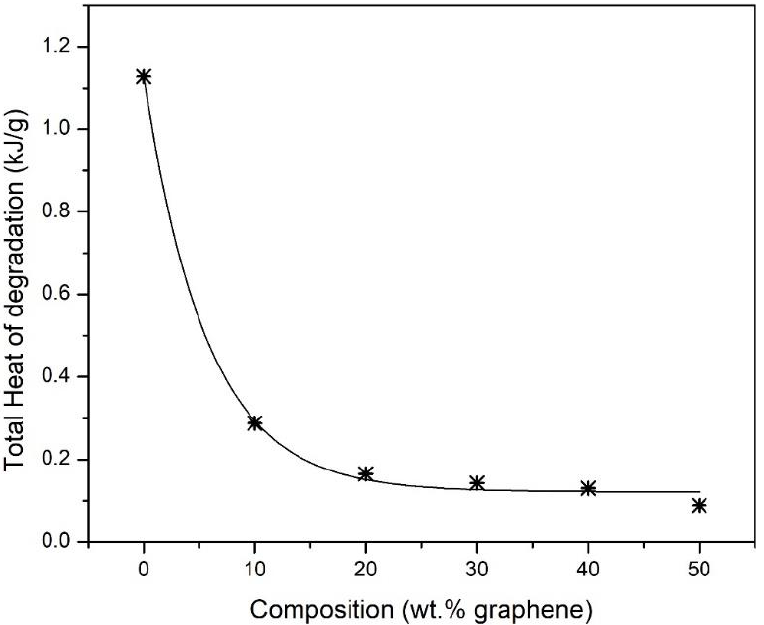
Figure 7. Total heat released during the degradation of PI and PINGS composites in nitrogen at a heating rate of 10 °C/min.